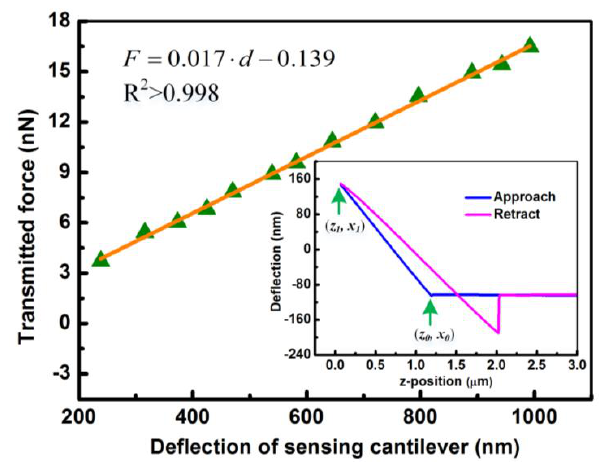
Figure 4. Transmitted force versus deflection for measuring the stiffness of the polymeric sensing micro-cantilever. Insert plots AFM force curves on the polymeric sensing micro-cantilever. The approach curve was used to calibrate the stiffness of polymeric sensing micro-cantilever.